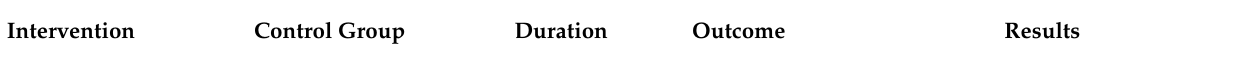
Table 2. Study design, population, intervention and control conditions, duration and outcomes measures of